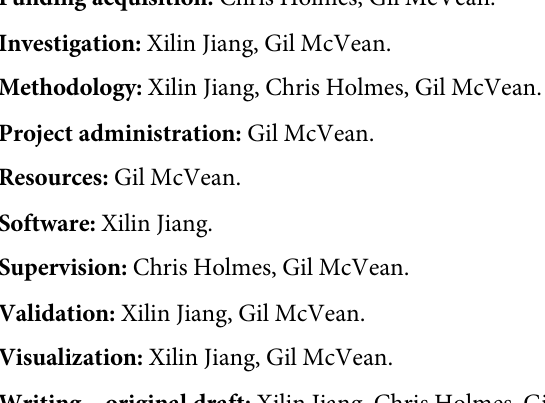
S7 Table. Comparison of risk between an early age group and a late age group. Comparison of baseline hazard rate (population-level risk), genetic risk factor effect size and absolute haz- ard rate (baseline hazard multiplied by genetic risk factor) for an early age group and a late age group across the diseases studied here. The genetic risk factor and absolute hazard are com- puted from the group with the highest decile of genetic